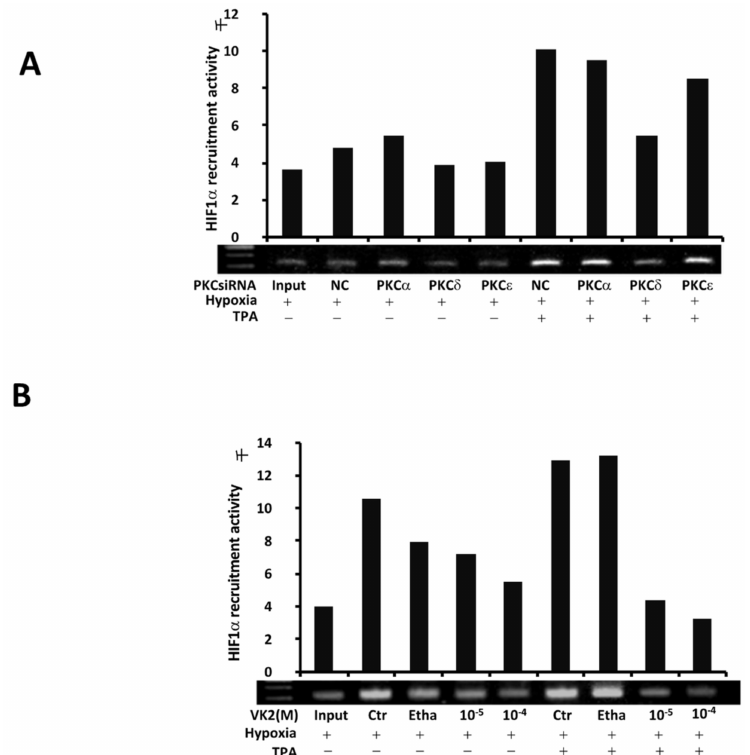
Figure 3. PKC- δ controlled the TPA-induced recruitment of HIF-1 α to the VEGF promoter region, and VK2 abrogated the induction of HIF-1 α recruitment by TPA in Huh7 cells. After treatments, the cells were harvested immediately and subjected to subsequent ChIP assays as described in the Materials and Methods. ( A ) The effects of PKC isoforms on TPA-induced HIF-1a recruitment. Cells were treated with isoform-specific PKC siRNAs under hypoxic conditions, and a ChIP assay was performed immediately after treatment. Only PKC- δ knockdown abrogated the TPA-induced recruitment of HIF-1 α . ( B ) VK2 abrogated the effects of TPA on the HIF-1a recruitment activity under hypoxic conditions in Huh7 cells. Ctr, no treatment; Etha, Ethanol; NC, negative control